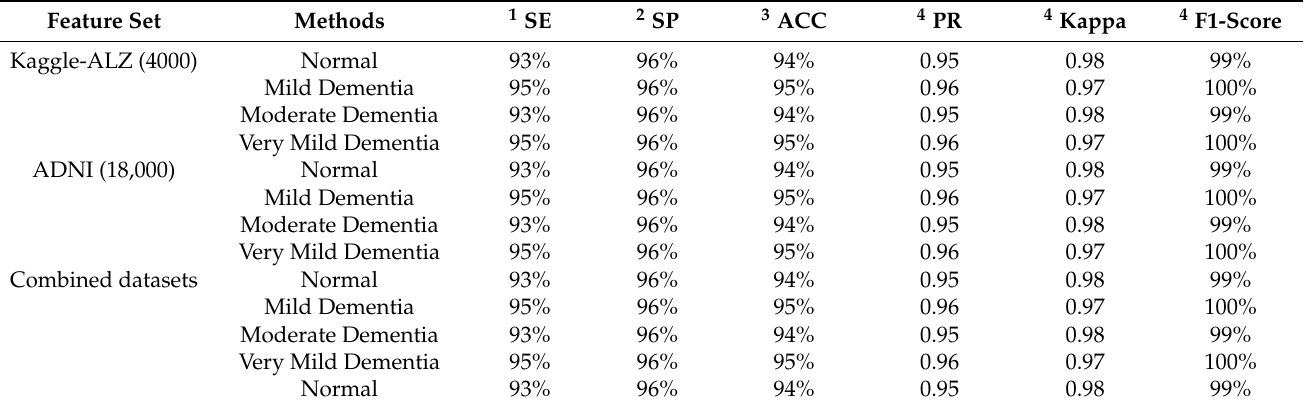
Table 6. Analysis results obtained using the cross-validation method of the proposed approach (k =